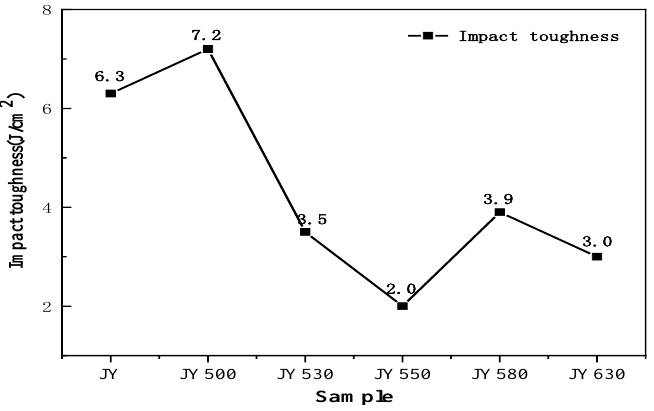
Figure 6. Impact toughness of HCCI samples treated at different quenching temperatures.